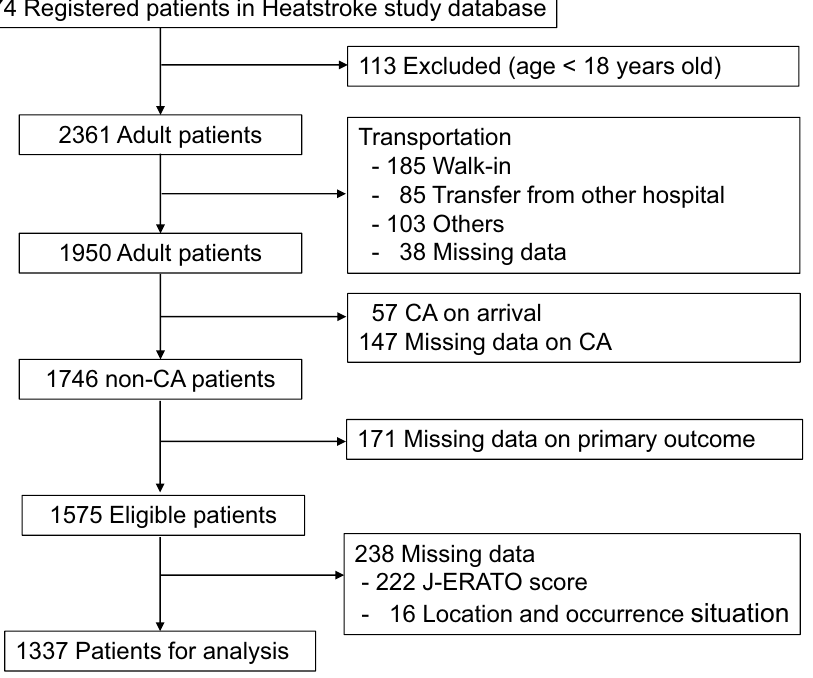
Figure 1. Patient flowchart. CA, cardiac